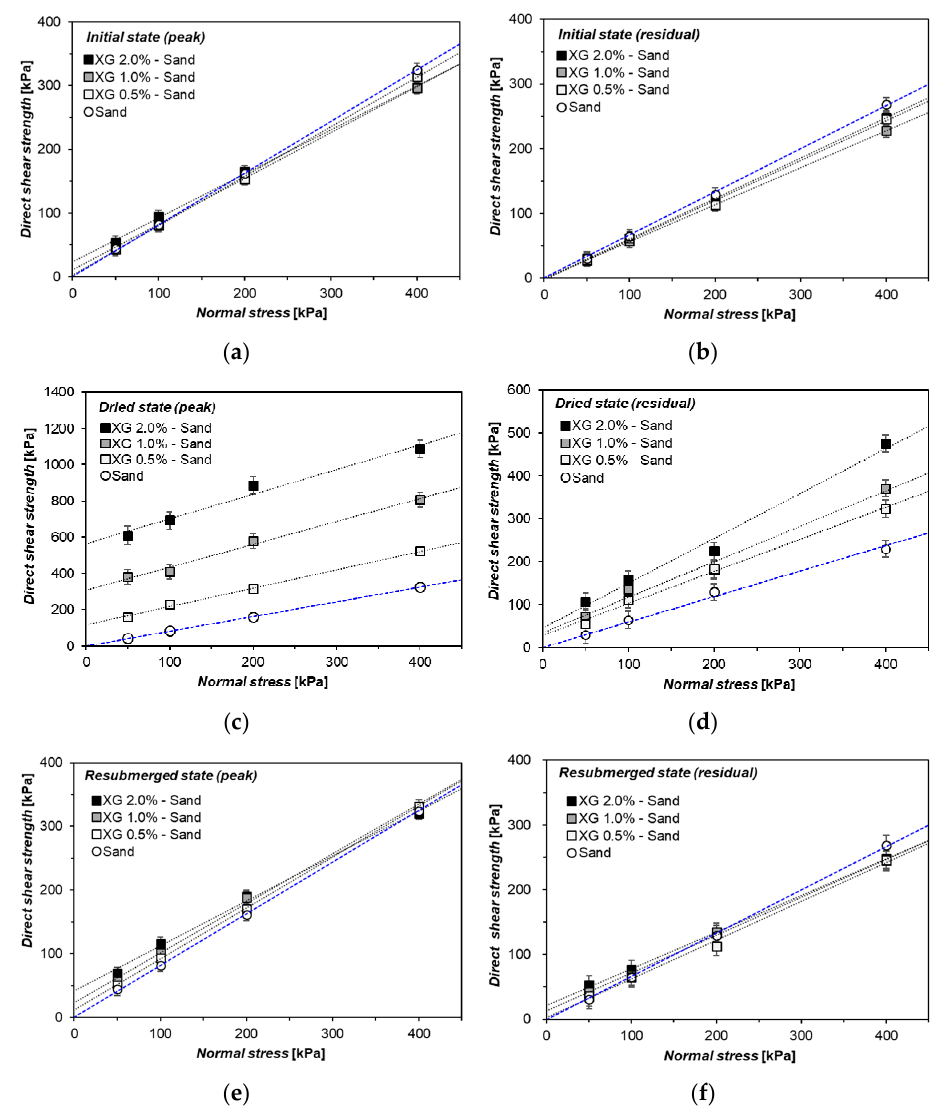
Figure 6. Peak and residual strength of xanthan gum-treated sand: ( a , b ) initial condition; ( c , d ) dry condition; ( e , f ) resubmerged condition.